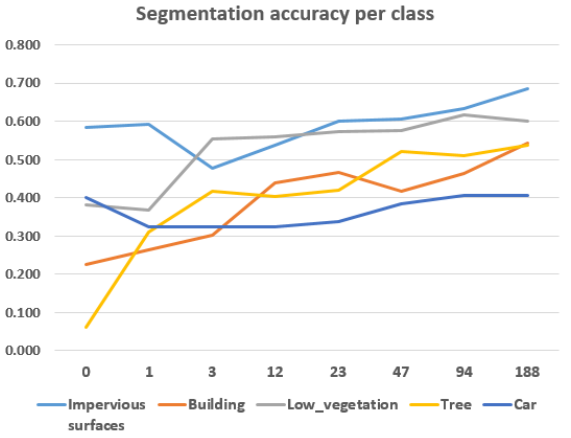
Figure 17. Segmentation accuracy per class for different sizes of the labeled images from the target